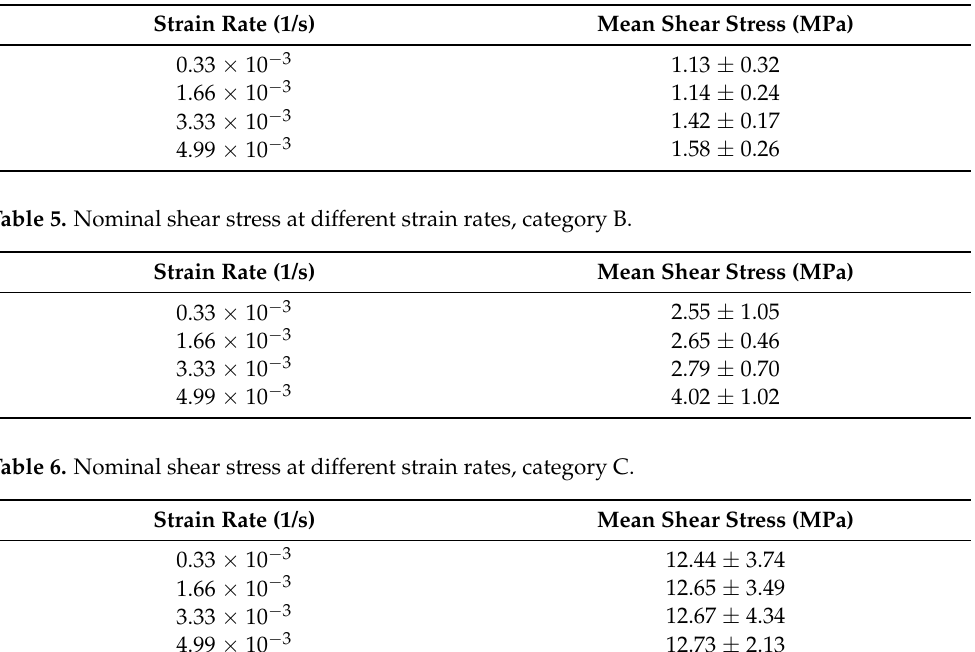
Table 4. Nominal shear stress at different strain rates, category A.